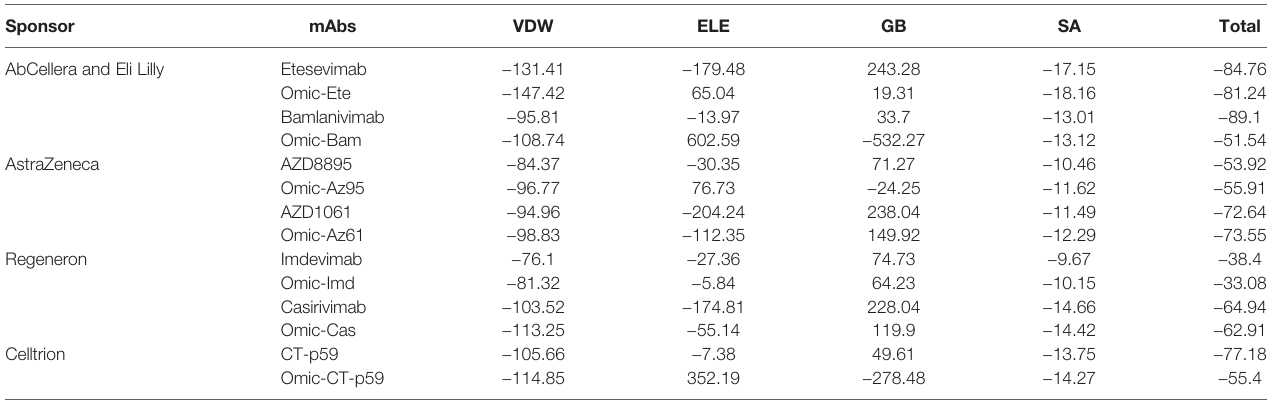
TABLE 2 | The binding energies of RBD Omic and RBD WT with seven therapeutic mAbs are